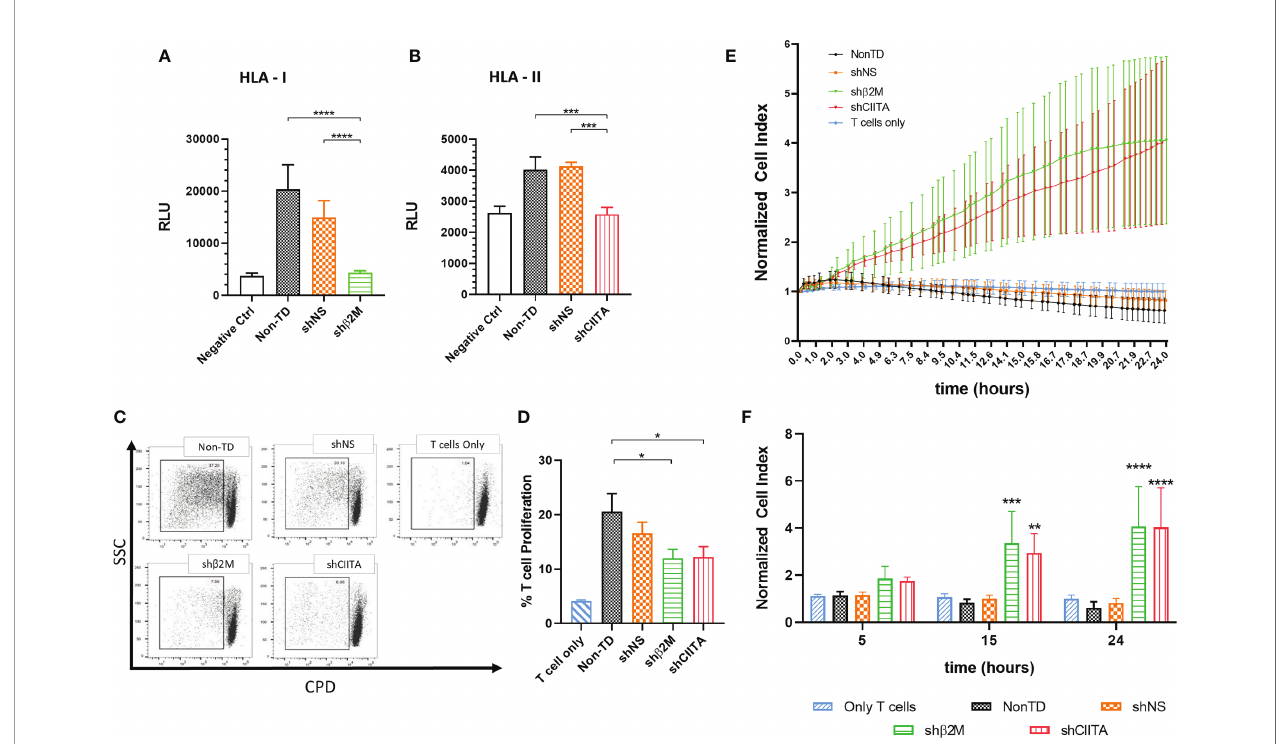
FIGURE 5 | Silencing HLA class I and class II expression shows a protective effect against antibody mediated cellular cytotoxicity and T cell cytotoxicity. (A) Antibody-dependent cellular cytotoxicity is reduced during incubation of limbal stem cells with speci fi c antibodies against HLA class I and (B) class II molecules, and T effector cells (n=4). (C) Representative dot-plots depicting T cell proliferation. (D) Bars represents mean percentage of T cell proliferation after 8 days in co-culture with b 2M-silenced (sh b 2M), CIITA-silenced (shCIITA), non-silenced (shNS) or non-transduced (Non-TD) limbal stem cells (n=6). (E) Normalized cell index of silenced (sh b 2M and shCIITA) and non-silenced (shNS and Non-TD) limbal stem cells co-culture with pre-primed T cells (n=4). (F) Representative time points after addition of pre-primed T cells. One-way ANOVA was used to compare differences between groups and data are presented as mean ± SD, *p < 0.05 , **p < 0.01 , ***p < 0.001 , ****p < 0.0001. RLU, relative luminescence